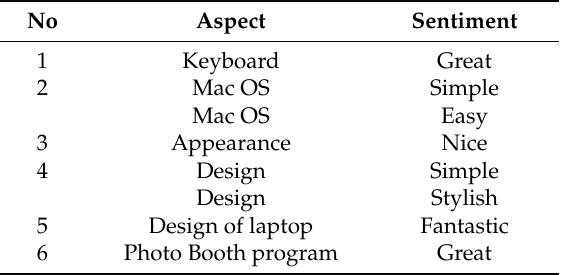
Table 2. Decomposed view of opinions in review sentences